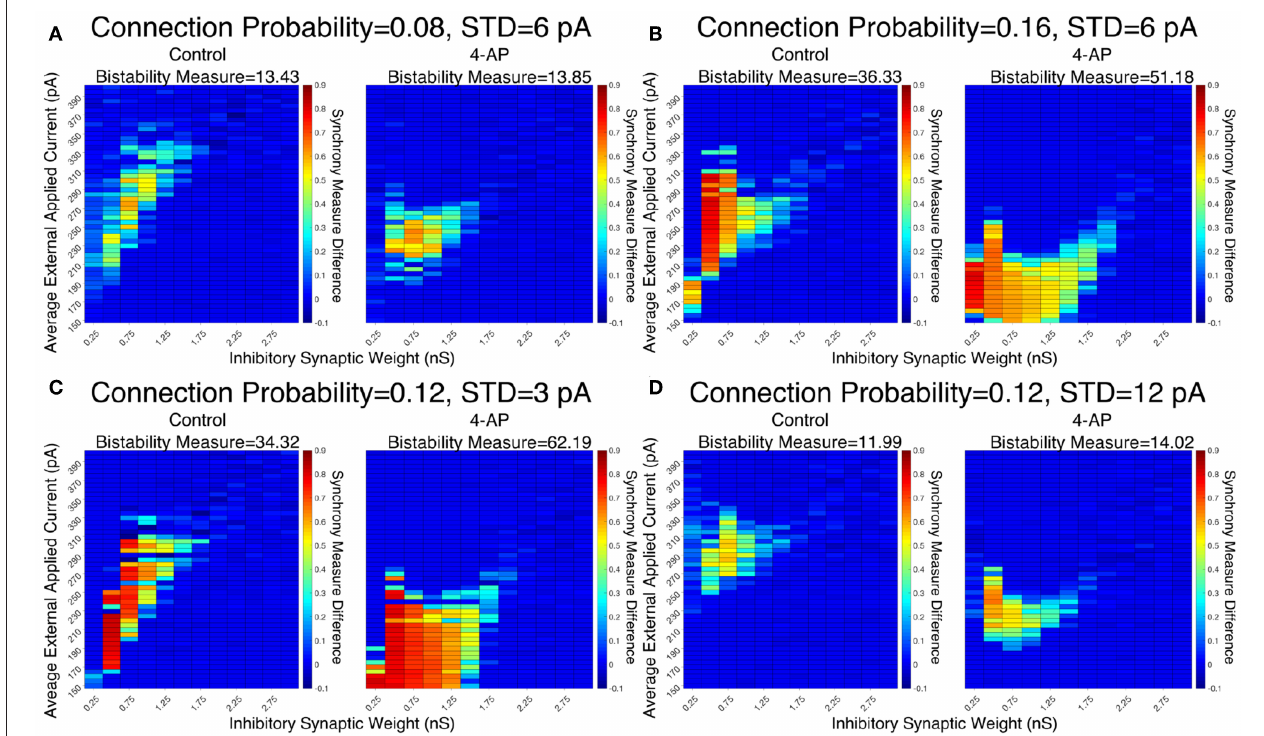
FIGURE 5 | Networks containing model 4-AP neurons exhibit bistability more robustly than control networks for a variety of network parameters. (A–D) Heatmaps displaying the difference between the Synchrony Measure following a modeled perturbation and from randomized initial conditions for control networks (left) and 4-AP networks (right). In these heatmaps, the inhibitory synaptic weight is varied along the x-axis and the average external applied current is varied along the y-axis. The Bistability Measure for each condition is shown above the corresponding panel. Results for a connection probability of 0.08 and standard deviation of 6 pA are shown in (A) , results for a connection probability of 0.16 and standard deviation of 6 pA are shown in (B) , results for a connection probability of 0.12 and standard deviation of 3 pA are shown in (C) , and results for a connection probability of 0.12 and standard deviation of 12 pA are shown in (D) . In all cases, 4-AP model networks exhibit a larger parameter regime showing behaviors indicative of a bistability than analogous control networks, shown both by more warm colors in the heatmap and the increased Bistability